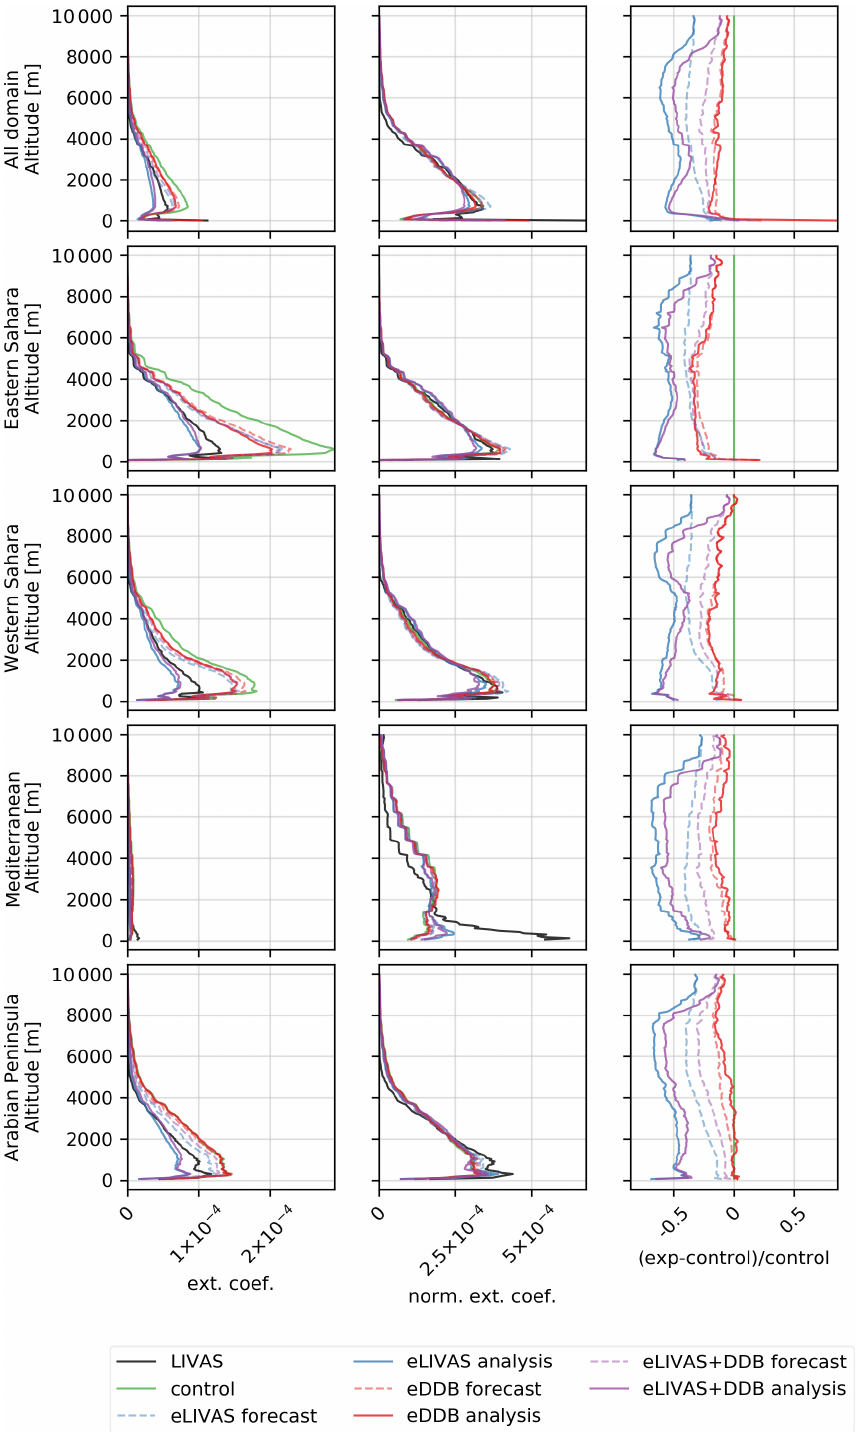
Figure 4. Collocated average dust extinction coefficients from model experiments and LIVAS-assimilated observations in the four- dimensional domain. The left column shows the mean extinction coefficient profiles in m − 1 . The middle column shows the mean extinction profiles but normalized such that the vertical integration of each profile in the panel equals 1. The right column shows the relative difference between the mean value of each experiment and the control run. Each row represents a different geographical domain defined in Fig. B1, from top to bottom, as the full domain, Eastern Sahara, Western Sahara, the Mediterranean, and the Arabian Peninsula.